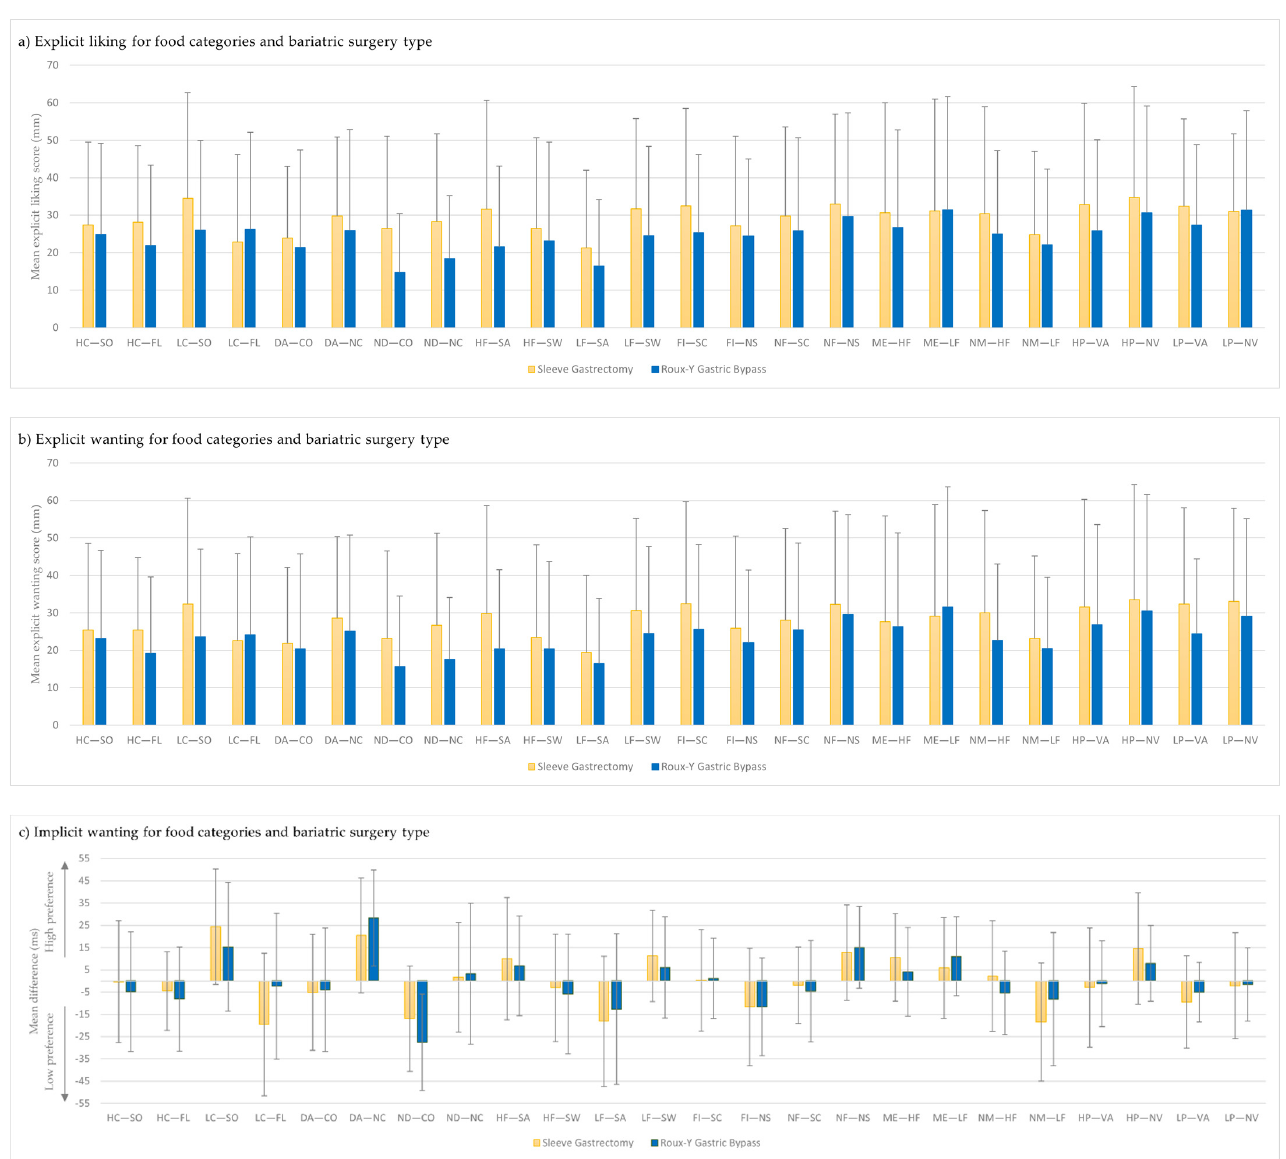
Figure 1. Relationship between ( a ) explicit liking, ( b ) explicit wanting and ( c ) implicit wanting for foods and bariatric surgery type. Food categories tested with the Leeds Food Preference questionnaire are indicated on the x -axis. Abbreviations: CO, color; DA, dairy; FI, fiber; FL, fluid; HC, high carbohydrate; HF, high fat; HP, high protein; LC, low carbohydrate; LF, low fat; LP, low protein; ME, meat; NC, no color; ND, non-dairy; NF, no fiber; NM, no meat; NS, no sauce; NV, no variation; OB: non-operative patients with obesity; SA, savory; SC, sauce; SO, solid; SW, sweet; VA, variation. Data are presented as mean